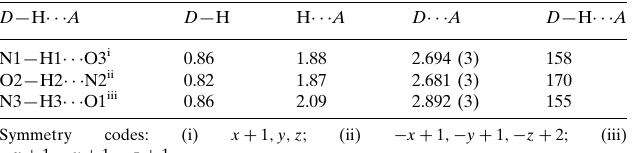
Hydrogen-bond geometry (A˚ , (cid:1)